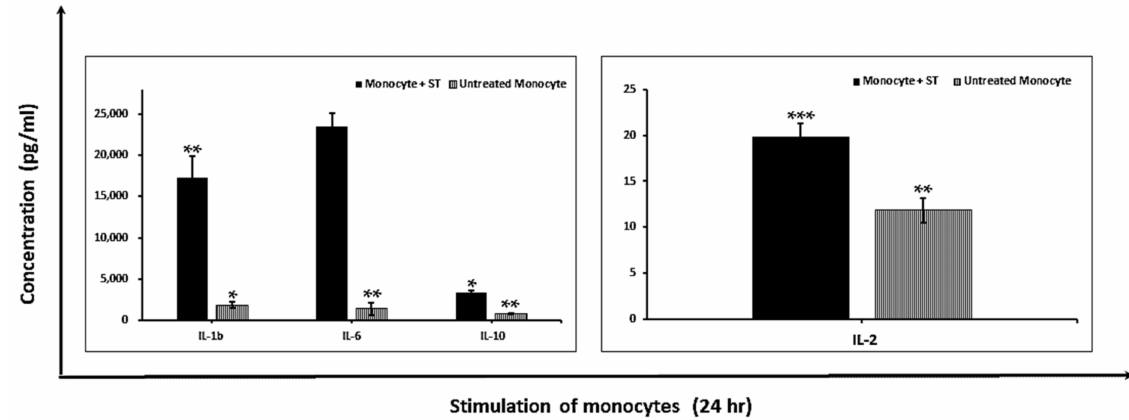
Figure 3. ST285 increases anti-inflammatory cytokine production by human monocytes. Human monocytes ( n = 3) were stimulated with ST285 for 24 h and secretion of IL-1 β , IL-2, IL-6, and IL-10 were measured. Treated human monocytes ( n = 3) with ST285 probiotic bacteria are referred to as monocyte + ST, and human monocytes ( n = 3) cultured in media without any ST285 probiotic bacteria are referred to as untreated monocytes. The means of two different readings of three replicate experiments were measured and analyzed. The means of readings for n = 3 monocytes were calculated and presented as plus or minus ( ± ) the standard error of the mean. The symbols represent the p -value for Tukey’s test (one-way ANOVA) where * p < 0.05, ** p < 0.01, and *** p <